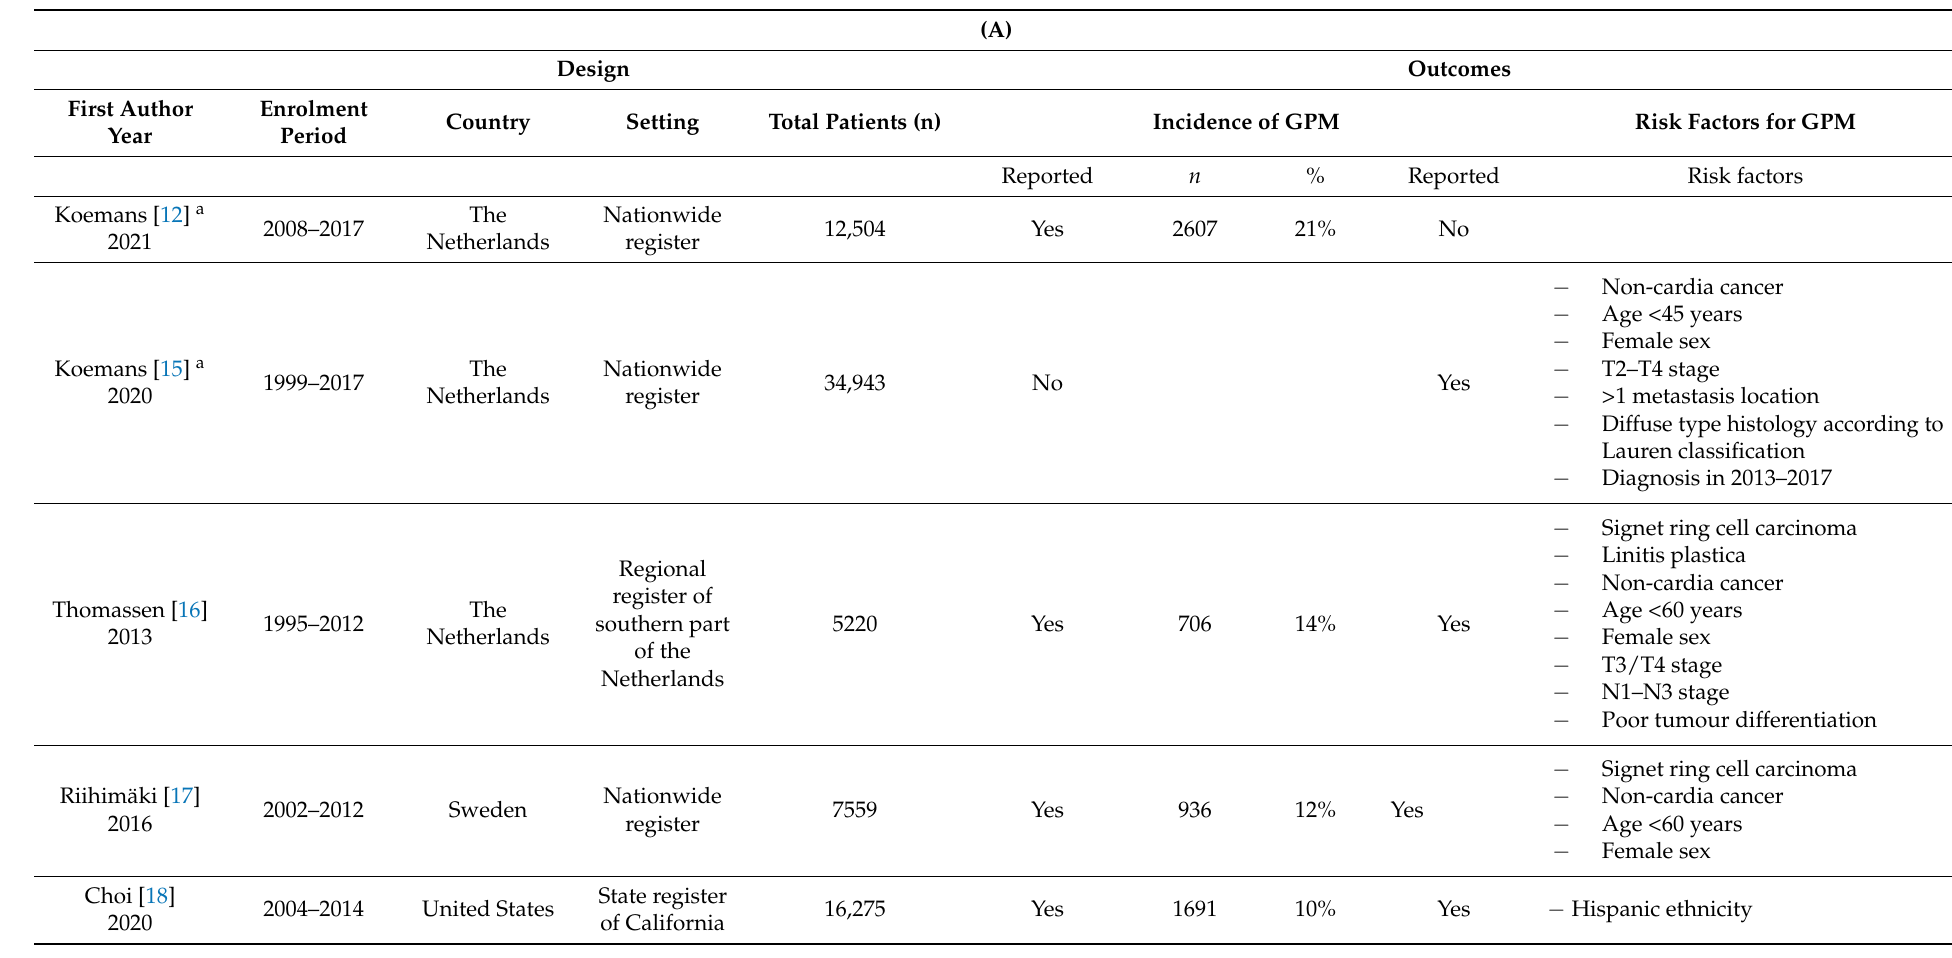
Table 1. Study characteristics of ( A ) population-based studies and ( B ) observational cohort